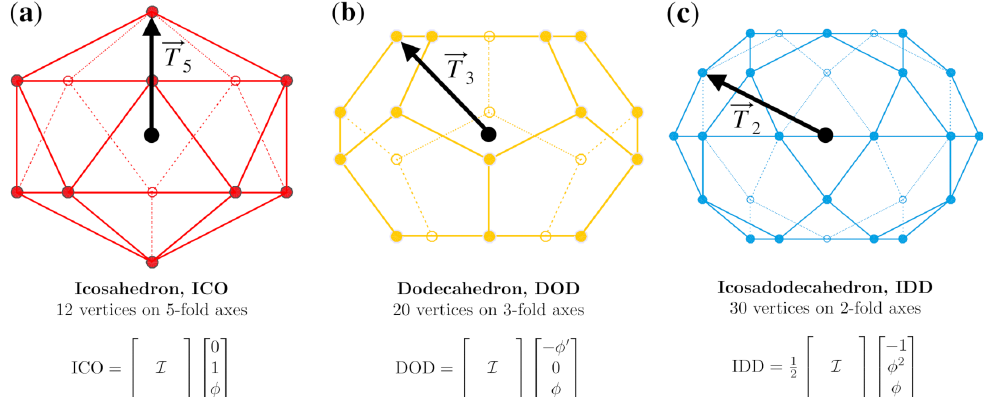
Figure 3. The three standard polyhedra with icosahedral symmetry and the affine extension translation vectors. ( a ) The 12 vertices of the icosahedron are on the six 5-fold axes, and the structure is generated by applying all 60 icosahedral rotations on a single point [ 0,1, φ ] , which also serves as the translation vector (cid:126) T 5 . ( b ) The 20 vertices of the dodecahedron are on the ten 3-fold axes, and the structure is generated by applying the full icosahedral group to the point [ − φ (cid:48) ,0, φ ] , which also serves as the (cid:126) T 3 translation vector. ( c ) The 30 vertices of the icosadodecahedron are on the fifteen 2-fold axes, and the [ − 1, φ 2 , φ ] , which serves as structure is generated by applying the full icosahedral group to the point 1 2 the (cid:126) T 2 translation vector.